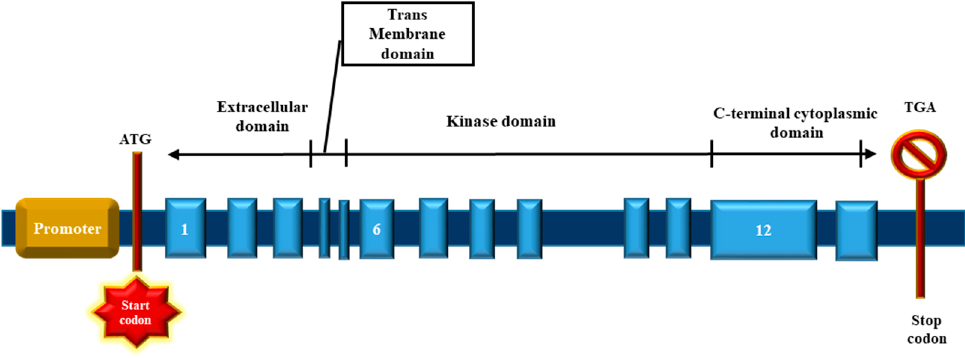
Figure 5. Diagrammatic representation of BMPR2 gene . The BMPR2 comprises 13 exons that en ‐ codes the extracellular ligand ‐ binding domain (exons 1 to 3), transmembrane membrane domain, (exons 4 to 5), kinase domain (exons 6 to 11), and the C ‐ terminal tail domain (exons 12 to 13).